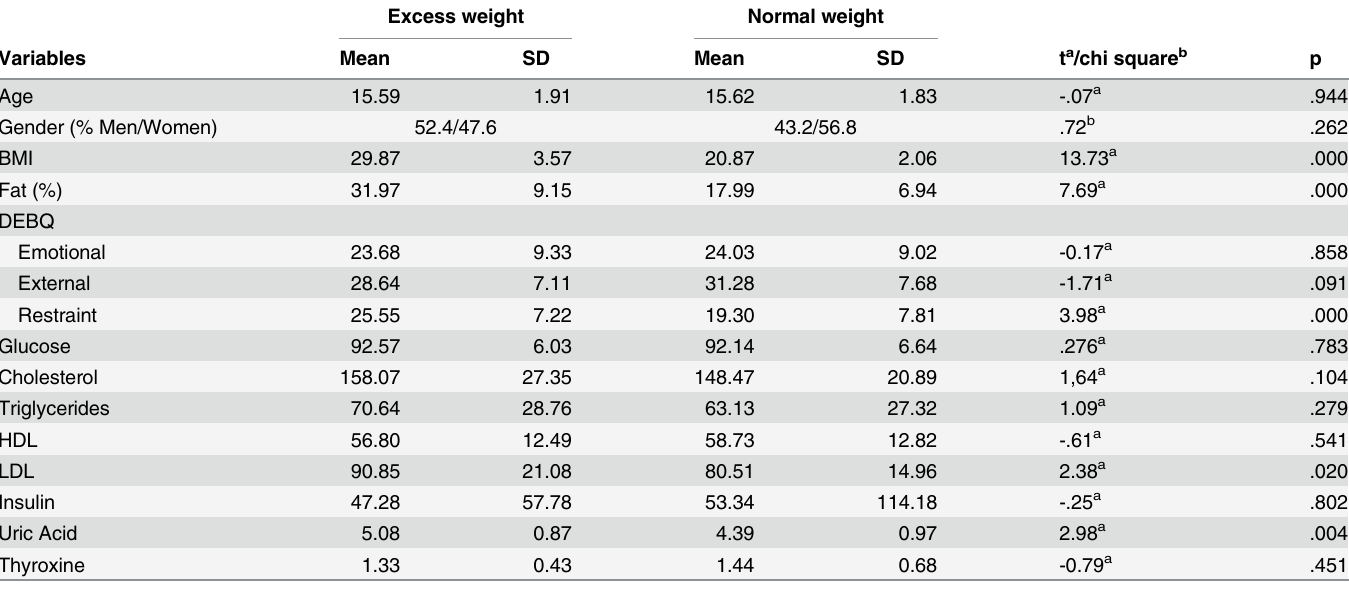
Table 1. Descriptive scores for the demographic, biometric and blood count characteristics of adolescents with excess and normal